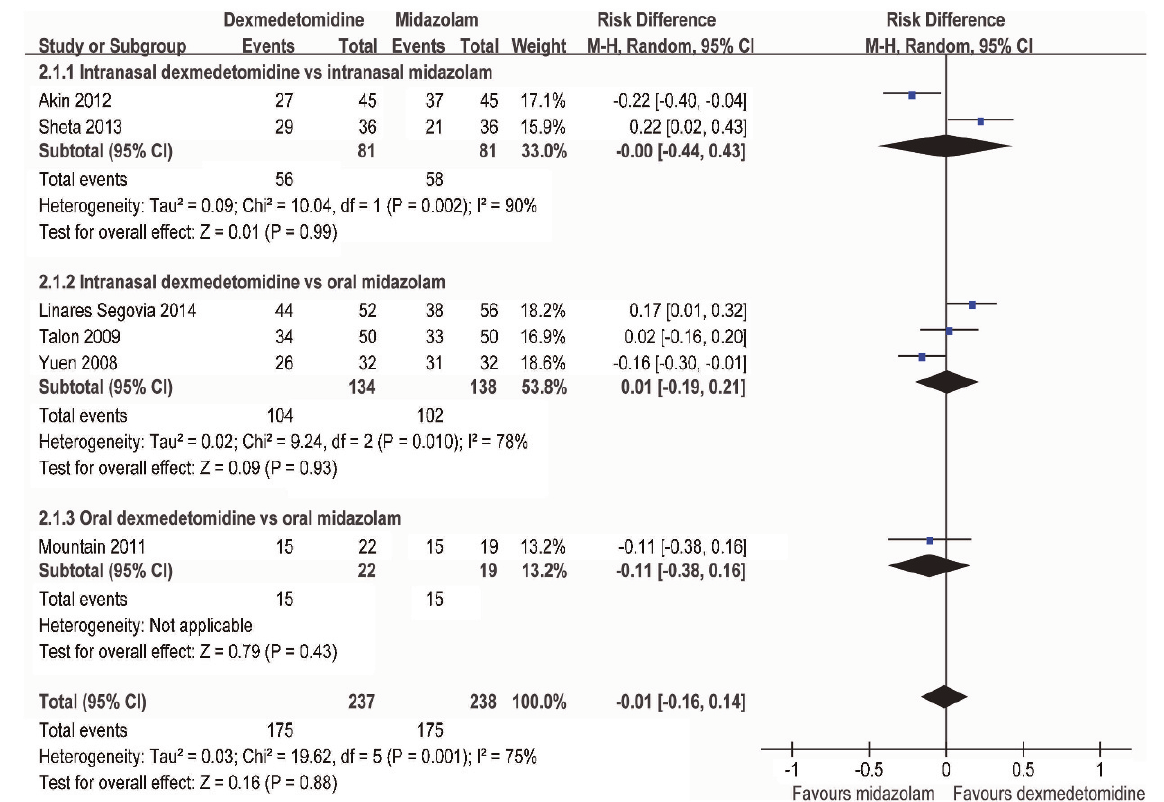
Figure 3 - Meta-analysis of satisfactory mask induction in children treated with dexmedetomidine vs